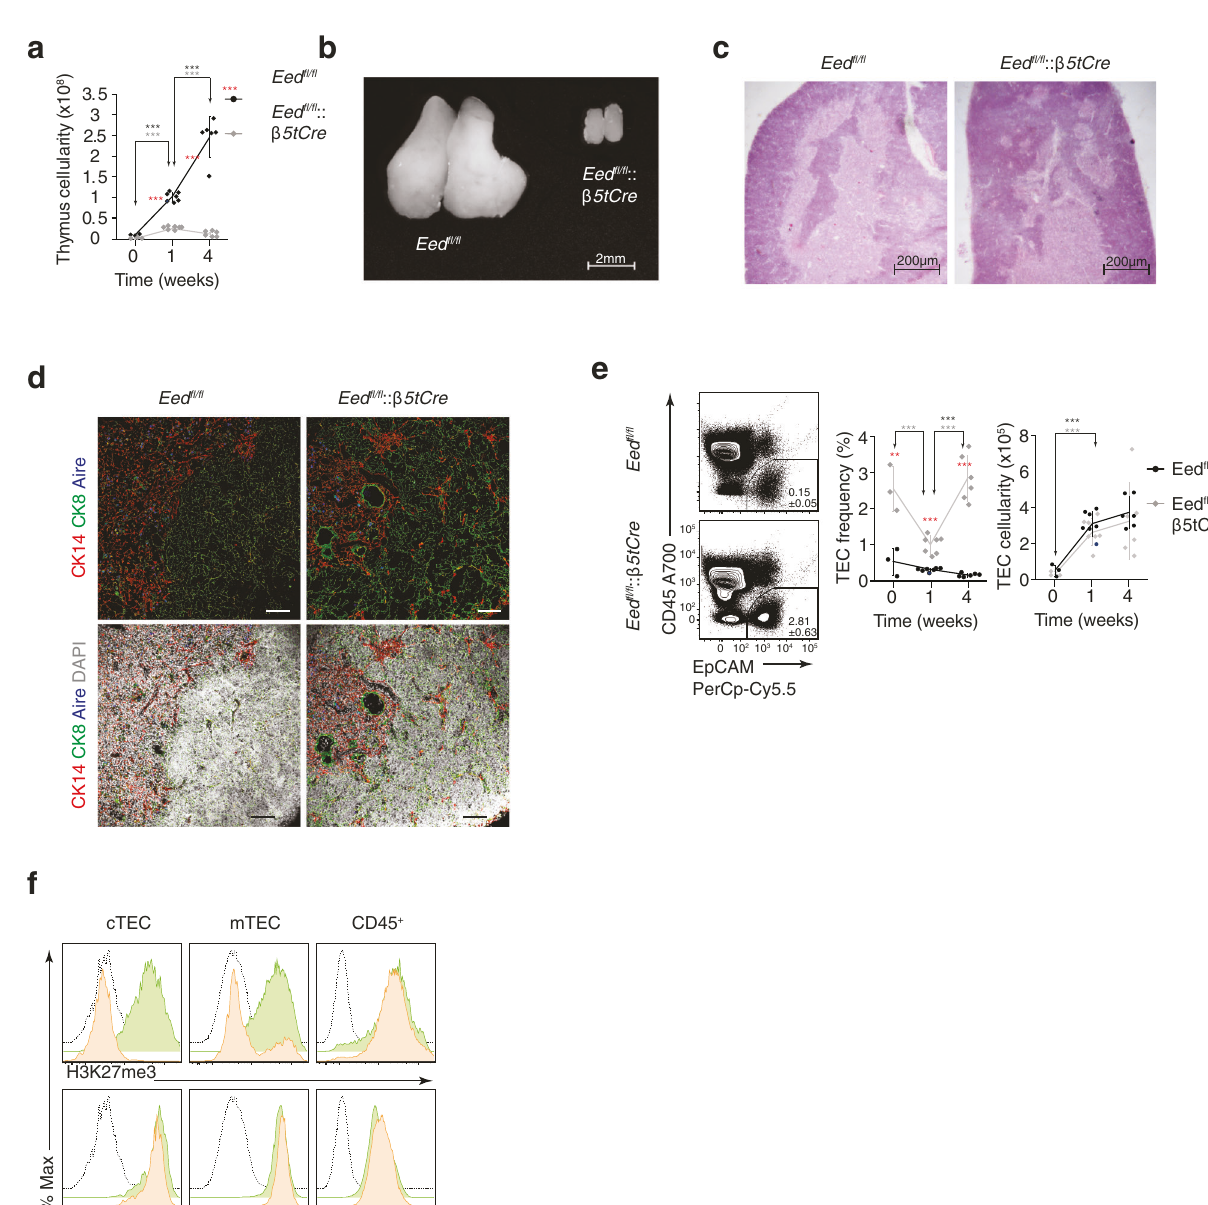
Fig. 1 Thymus phenotype of Eed fl / fl :: β 5tCre mice. a Absolute thymus cellularity of mutant (grey diamonds) and control mice (black circles) at the indicated postnatal ages (week 0 relates to newborn). b Macroscopic and c microscopic comparison of thymic lobes isolated from 4-week-old Eed fl / fl : : β 5tCre and control Eed fl / fl mice. Scale bars represent 2 mm and 200 µ m, respectively. Tissue sections were stained with haematoxylin and eosin. d Immunohistology of thymus sections prepared from 4-week-old Eed fl / fl and Eed fl / fl :: β 5tCre mice and stained for cytokeratin (CK) 8 (green, a cTEC marker), CK14 (red, an mTEC marker), AIRE (blue) and DAPI (grey; only in lower panels). Scale bars represent 50 µ m. e Relative frequency and absolute cellularity of TEC isolated from Eed fl / fl : : β 5tCre (grey diamonds) and control Eed fl / fl mice (black circles) at indicated ages. Contour plots show representative fl ow cytometric analyses of thymic single-cell suspensions of 4-week-old mice, the gating for TEC and their relative frequencies. f Detection of H3K27me3 marks and histone H3 protein in mTEC, cTEC and CD45 + cells isolated from Eed fl / fl :: β 5tCre and Eed fl / fl mice at 4 weeks of age. Isotype control stains for Eed fl / fl mice are indicated as IgG control. Data in graphs ( a , e ) represent mean and standard deviations (SD) and are pooled from independent experiments: week 0: n = 3, week 1: n = 7, week 4: n = 6; * p < 0.05, ** p < 0.01, *** p < 0.001 (two-tailed unpaired Student ’ s t test). Asterisks in red indicate comparisons between Eed fl / fl :: β 5tCre and Eed fl / fl mice, whereas black and grey asterisks compare results from identical mouse strains at different time points. Data in ( b – d , f ) are representative of two independent experiments with n = 3 mice each per strain investigated. n = biologically independent replicates per group. The gating for thymic epithelia is displayed in Supplementary Fig. 1. Source data including exact statistical test values are provided in the Source Data fi